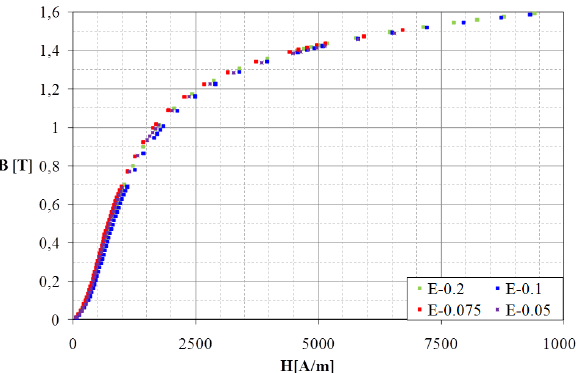
Figure 2: Magnetic characteristics for Epoxy SMC pressed at 800